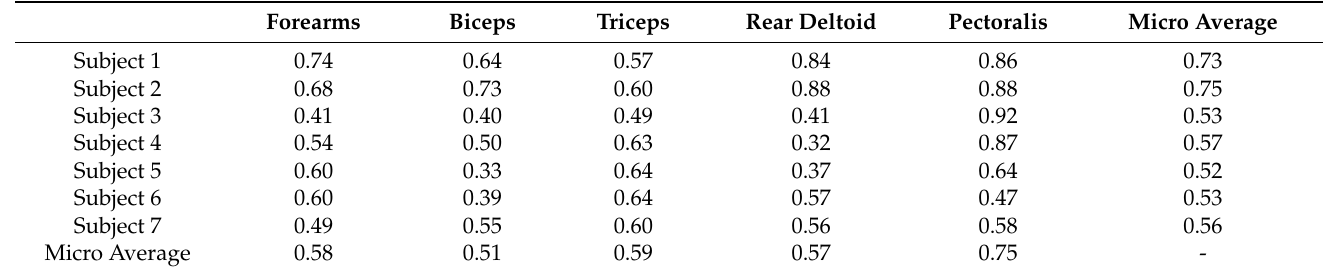
Table 1. The correlation coefficient between measured EMG values and proposed model estimated values. All correlation coefficients in the table are significant at a 0.1% level.